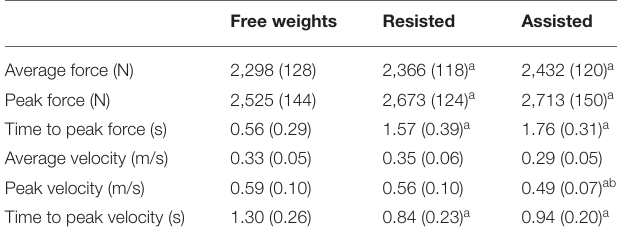
significance. Based on the calculation a minimum of 15 subjects needed to be recruited to the study.